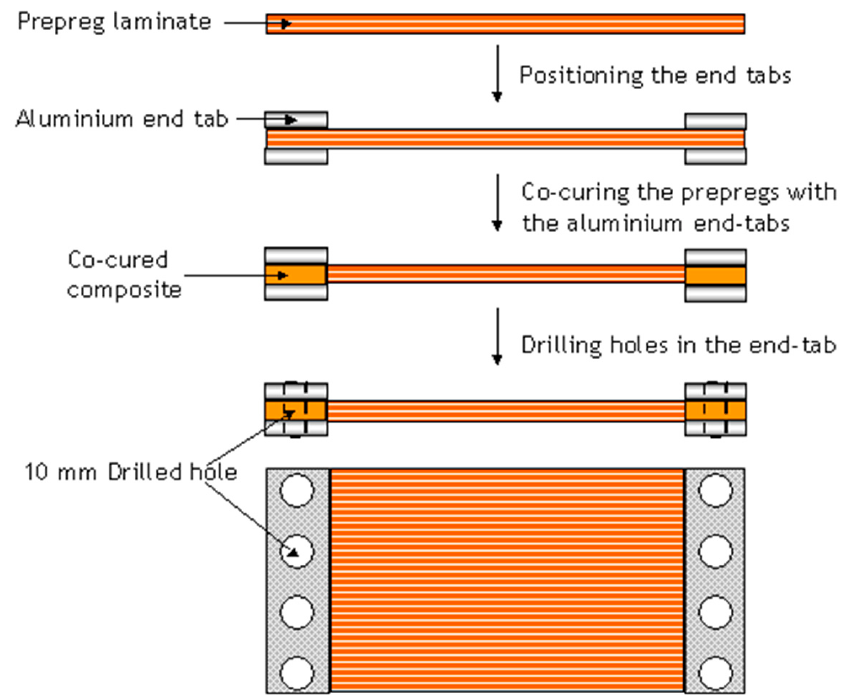
Figure 10. Schematic illustration depicting the sequence of operations that were carried out to co-cure the aluminium end-tabs on to the prepregs (within the end-tab region).